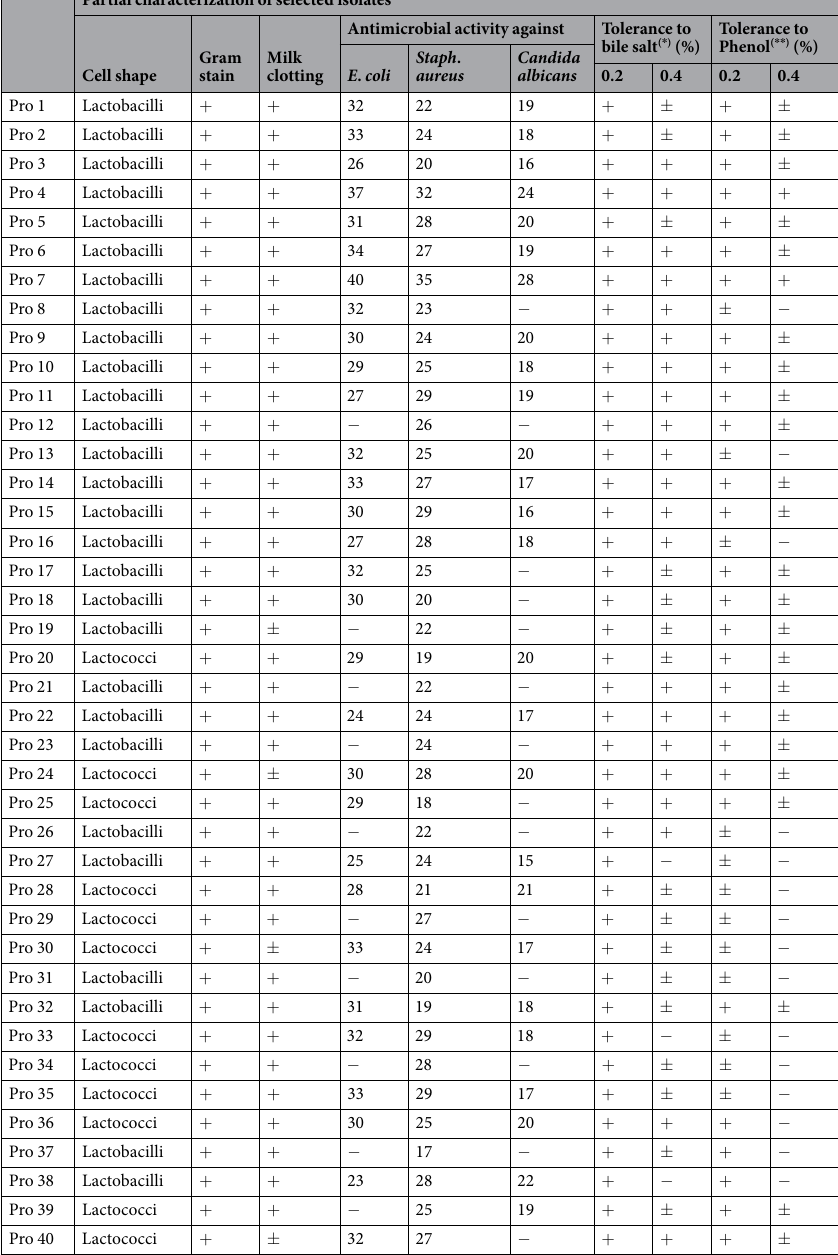
Table 1. Preliminary screening for probiotic strains isolated from different raw and fermented camel milk. Notes: Capability of lactic acid bacterial isolates to grow on bile salt or phenol was determine by streaking loopfullof each fresh isolate into MRS agar plates containing (0.2 or 0.4%) phenol or bile salt compared to control (without bile salt and phenol) and anaerobically incubated at 37 °C for 24 h. The Score of growth was recorded as: − negative growth; + / − weak growth; + good